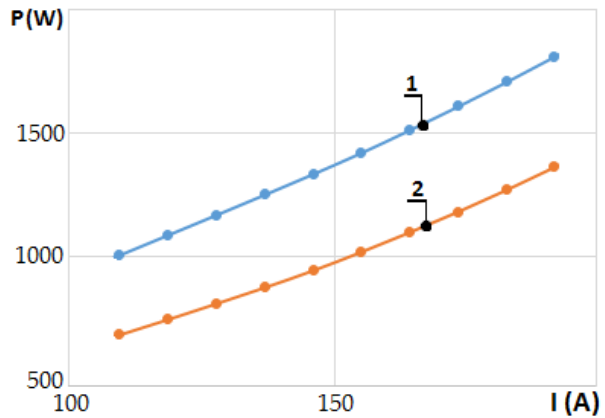
Figure 9. Boost mode of operation. 1–DC–DC power stage losses; 2–Boost transistor Q2 switching and conductive losses (IGBT module M1); 3–Boost diode D2 losses (IGBT module M1); 4–Buck transistor Q1 losses, permanently switched ON (IGBT module M2); 5–Efficiency.